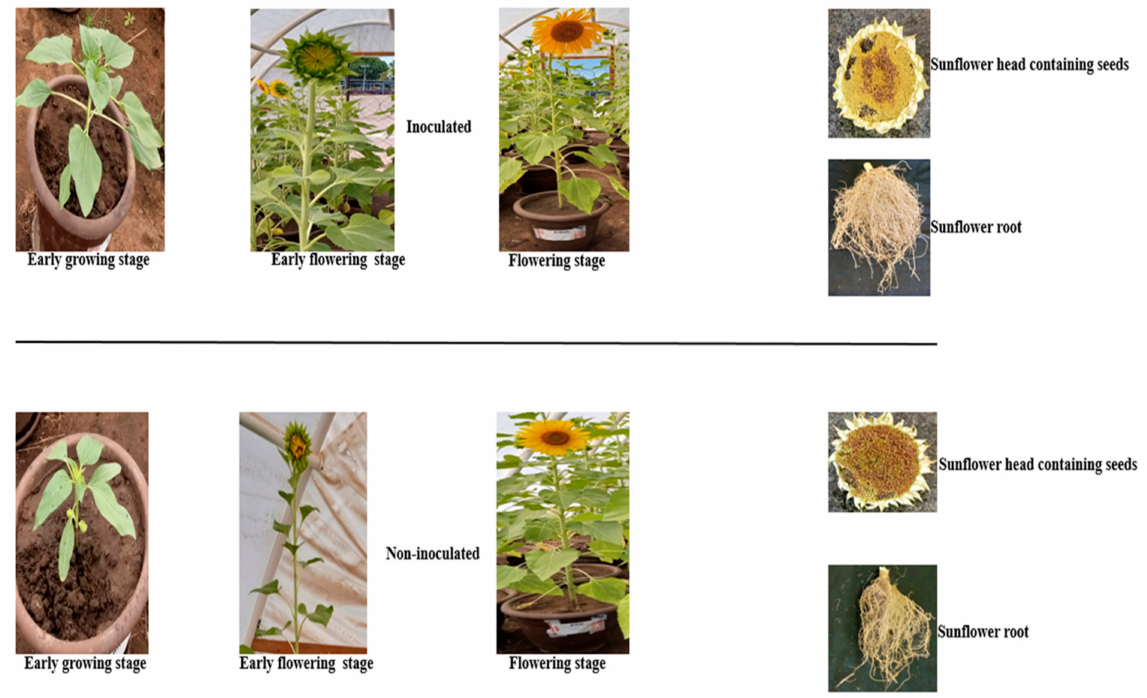
Figure 4. Inoculated and non-inoculated sunflower growth and yield